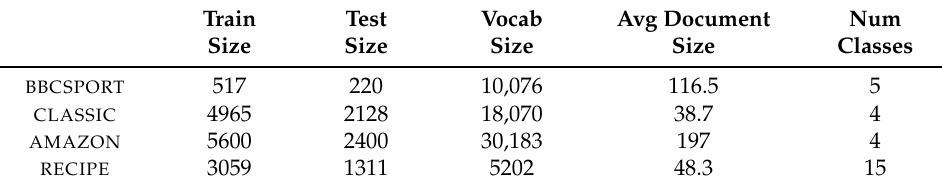
Table A2. Classification task dataset statistics.